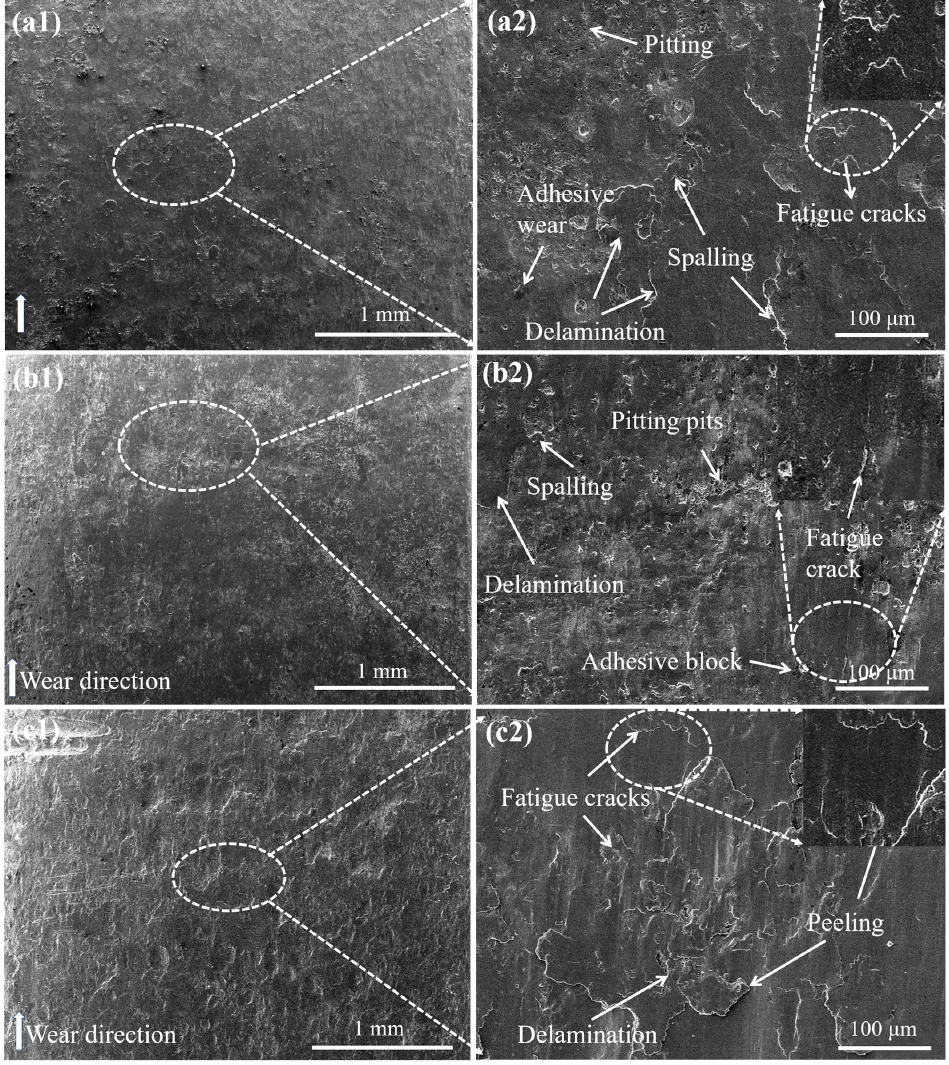
Figure 5. FESEM images of the wear surface of the test steel: ( a1 , a2 ) 80 km/h, ( b1 , b2 ) 120 km/h and ( c1 , c2 ) 150 km/h. ( c1 , c2 ) 150